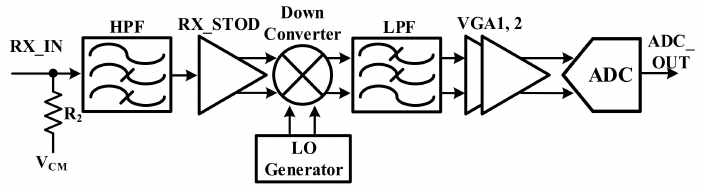
Figure 14. Architecture of the receiver.